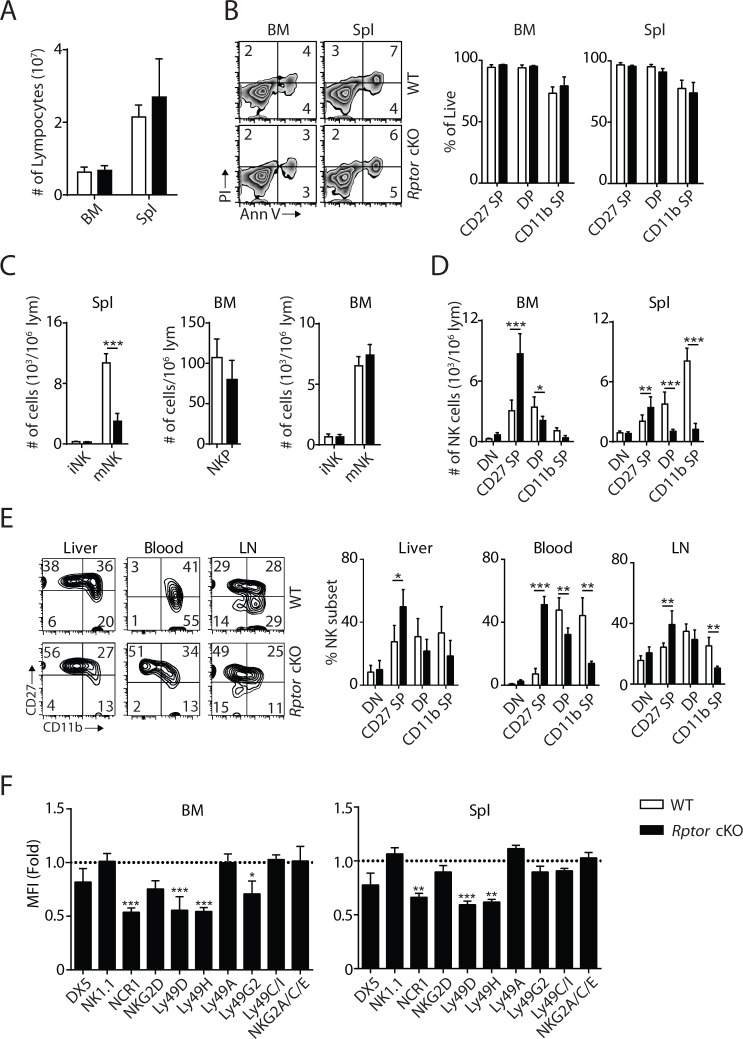
mTORC1 is required for NK cell maturation.(A) BM and spleen lymphocytes count in WT and Rptor cKO mice. n = 4 pooled from two independent experiments. (B) The viability of freshly-isolated NK cells from BM and spleen of WT and Rptor cKO mice was evaluated by Annexin V (Ann V) and Propidium iodide (PI) staining (left). Percentage of live cells (Ann V−PI−) in each population gated by CD27 and CD11b was quantified (right). n = 3 pooled from three independent experiments. (C) Number of iNKs (CD3−CD122+NK1.1+DX5−), mNKs (CD3−CD122+NK1.1+DX5+) in the spleen and NKPs (CD3−Flt3−CD27+2B4+CD127+CD122+ NK1.1−), iNKs, mNKs in the BM from Rptor cKO mice were quantified using flow cytometry. n = 3–5 pooled from two or three independent experiments. (D) Number of each NK cell population defined by CD27 and CD11b expression in BM and spleen was quantified as the number of cells per million lymphocytes. n = 7 pooled from four independent experiments. (E) CD27 and the CD11b expression on NK cells from liver, blood and lymph node (LN) were assessed by flow cytometry (left). Percentage of each NK subsets was quantified (right). n = 4 pooled from two to four independent experiments. (F) Expression of various maturation markers on NK cells was shown as fold change in MFI normalized to WT. n = 4 pooled from two independent experiments. All bar graphs present the mean ± SD. Statistical significance was calculated using two-way ANOVA. *p<0.05; **p<0.01; ***p<0.001.